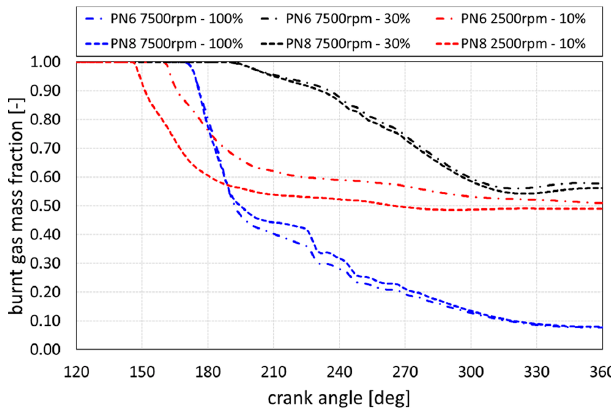
Figure 13. Differences in MFBG behavior during scavenging between the two prechambers.